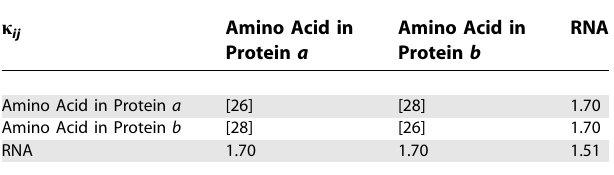
Table 2. The Contact Interaction Strengths Applied in Our Model